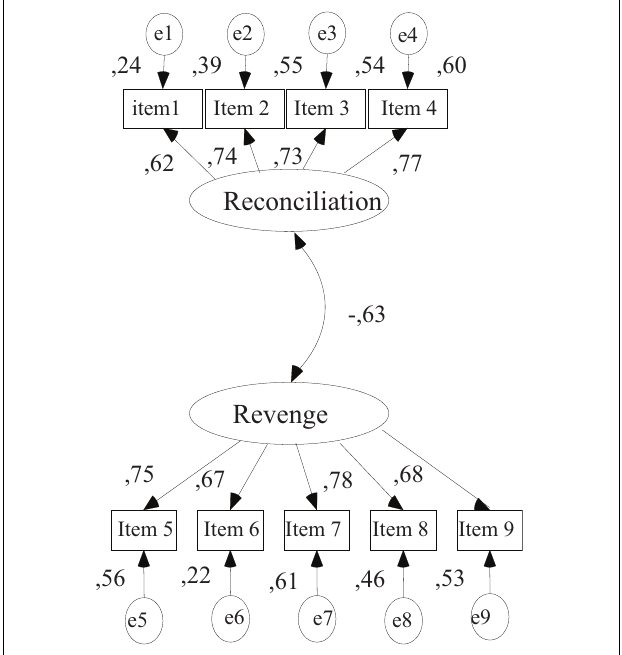
FIGURE 1 | Confirmatory factor analysis revenge and reconciliation